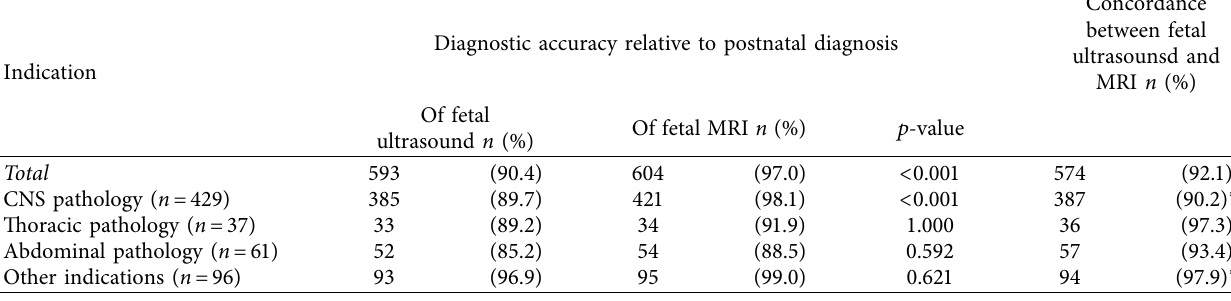
Table 3: Diagnostic accuracy of fetal ultrasound and fetal magnetic resonance relative to the postnatal diagnosis or autopsy and concordance ( n � 623).